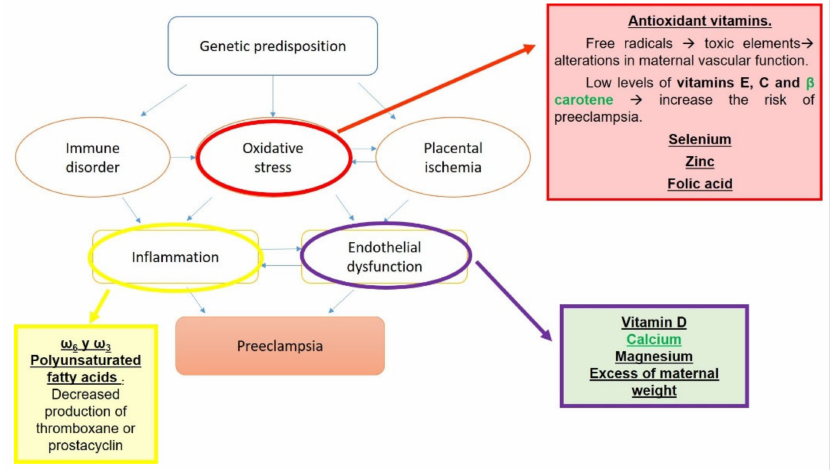
Figure 3. Risk factors for